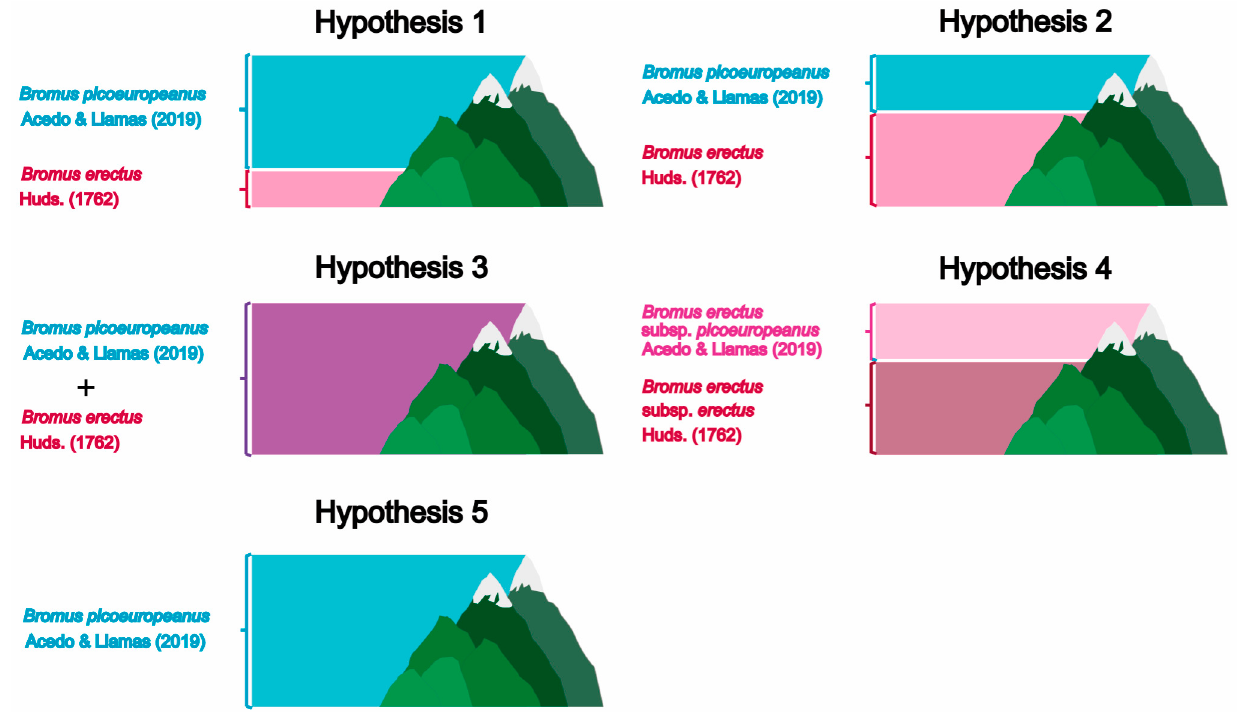
Figure 2. The five hypotheses of the occurrence of Bromus erectus s. s. and Bromus picoeuropeanus in Picos de Europa. Hypothesis 1 assumes that B. erectus s. s. and B. picoeuropeanus are two distinct species, being the altitudinal range of B. erectus s. s. described by Baˇciˇc and Jogan [38]; Hypothesis 2 also assumes the existence of two different species with the altitudinal range given by Acedo and Llamas [29] and Hudson [50]; Hypothesis 3 assumes the existence of two distinct species that would co-occur in Picos de Europa; Hypothesis 4 assumes that B. picoeuropeanus would be a subspecies of B. erectus s. s. with the altitudinal range proposed by Acedo and Llamas [29] for B. picoeuropeanus ; Hypothesis 5 assumes the existence of both species, B. picoeuropeanus being the only one found in Picos de Europa.